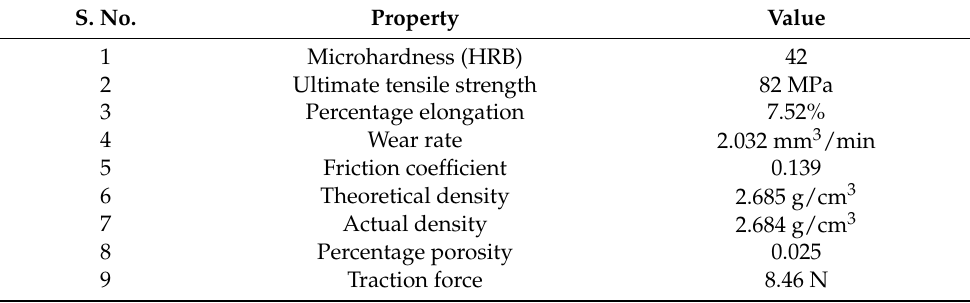
Table 1. Properties of base Al-Mg-0.6Si-0.35Fe alloy matrix. S. No.